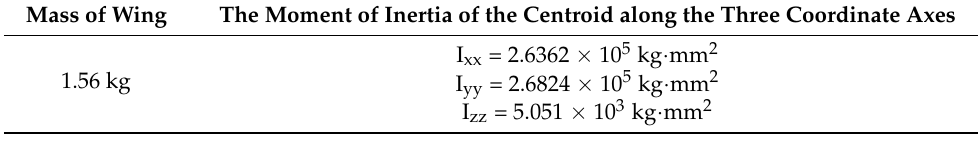
Table 1. Parameters of the wing.